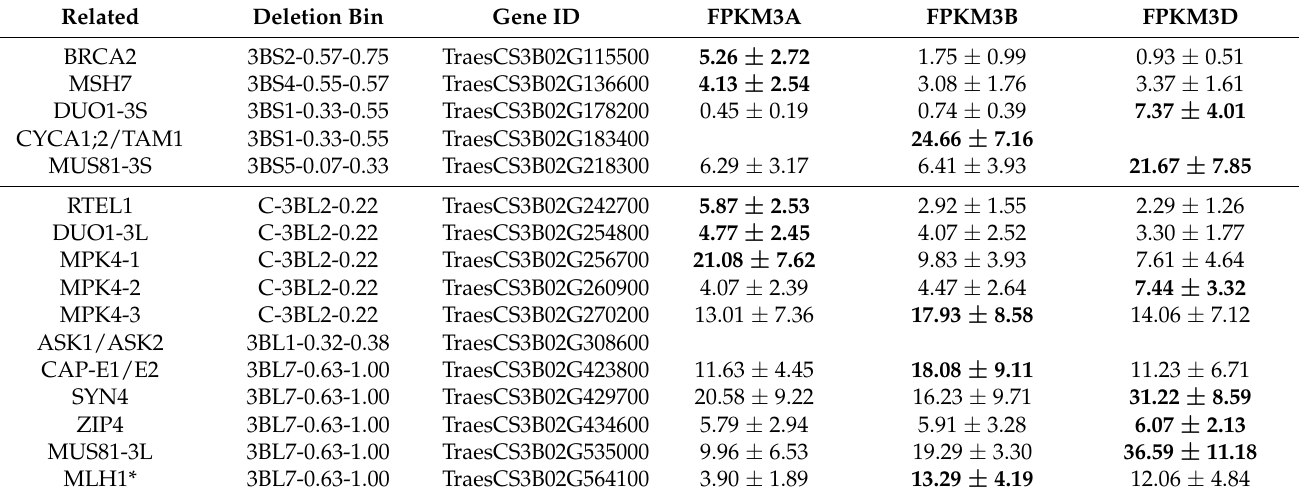
Table 3. Known meiotic genes assigned to chromosome 3B. Meiotic gene detected using model species protein (Arabidopsis) and exonerate alignment (score >500 identity >40% similarity >60%). Gene name determined according to Arabidopsis. Gene ID: ID of 3B-homoeologous copy gene in Triticum aestivum annotation. Deletion bin: Deletion bin where the gene is assigned. FPKM Values (average of four meiotic stages and two replicates [55]) are indicated for the three homoeologous copies when available; the most expressed copy is in